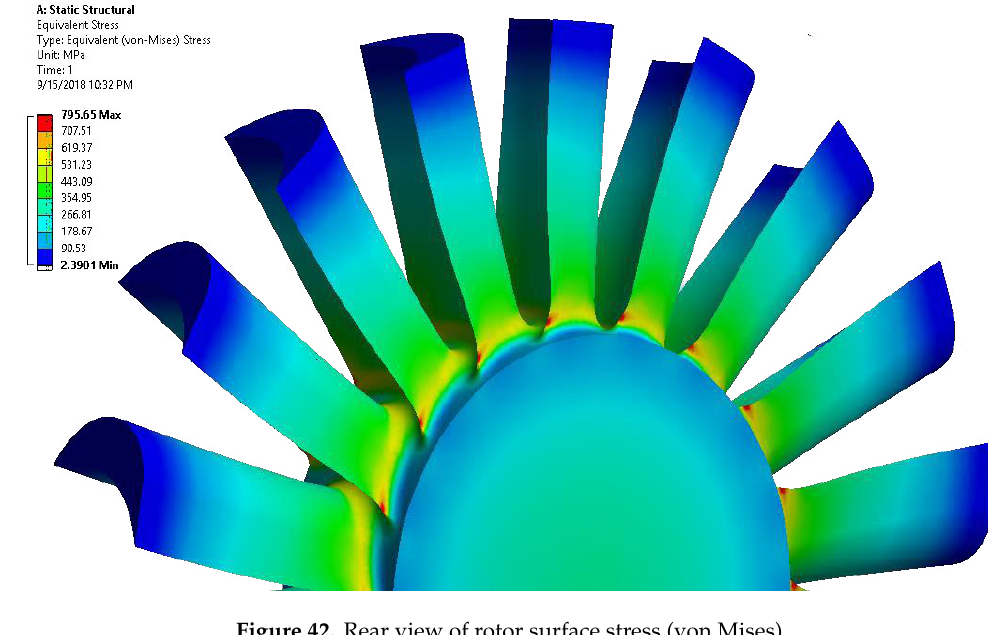
Figure 42. Rear view of rotor surface stress (von Mises).